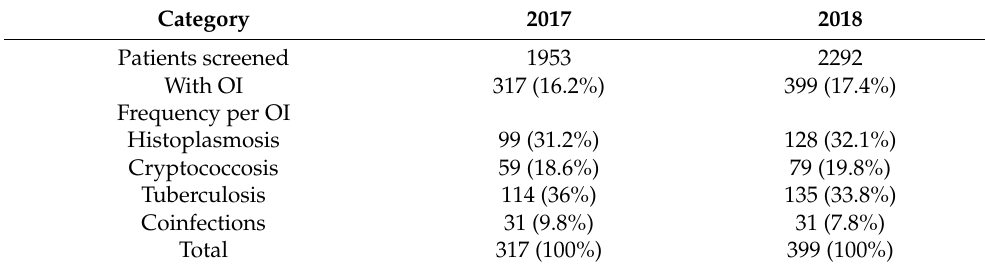
Table 1. Numbers of patients enrolled in the OI program between 2017 and